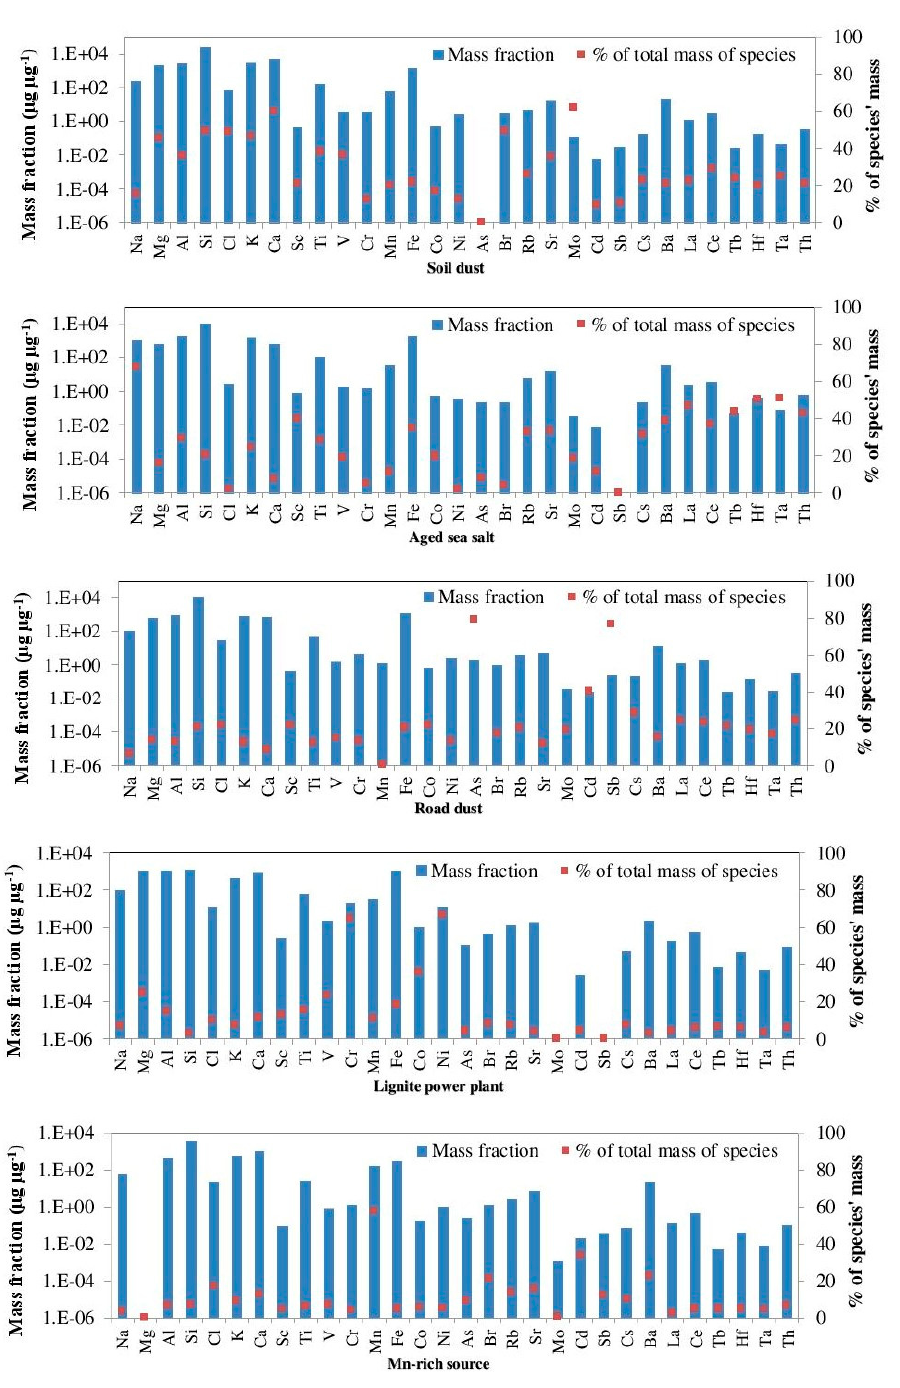
Figure 2. The chemical profiles of the soil dust, aged sea salt, road dust, lignite power plant, and Mn-rich source. The light blue bars (left axis) represent the concentrations as mass fractions, while the red dots (right axis) represent the percentage of each chemical element’s mass that is assigned to each source.